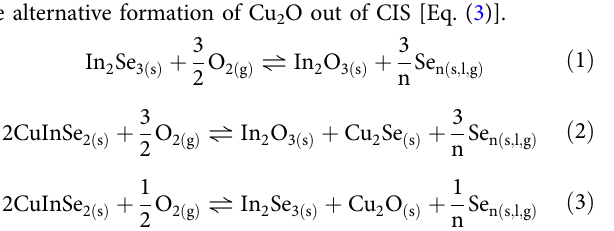
thin fi lms, as reported by Gödecke et al. 8 for bulk material. the alternative formation of Cu 2 O out of CIS [Eq. (3)].